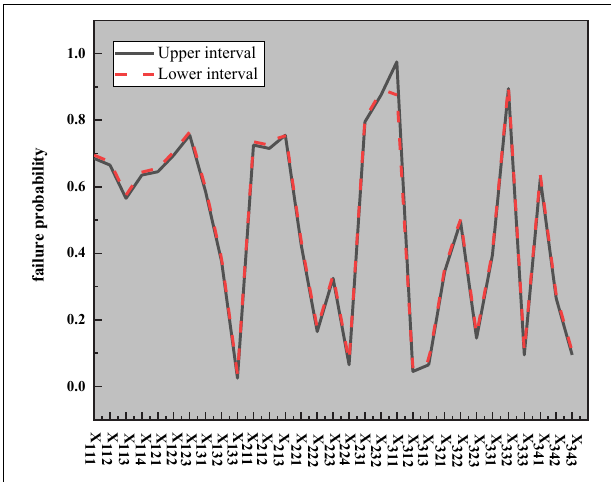
FIGURE 17 | Probability of each bottom event of IEE classroom teaching effectiveness in higher institutions. IEE, Innovation and Entrepreneurship Education.